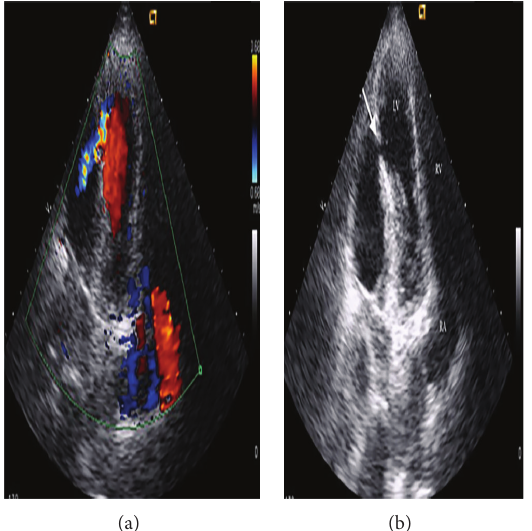
Figure 1: Modified apical four-chambered view in transthoracic echocardiography showing the defect (b) (marked by white arrow) and color jet (a) through it. LV: left ventricle, RV: right ventricle, RA: right atrium, and IMD: intramyocardial dissection area.